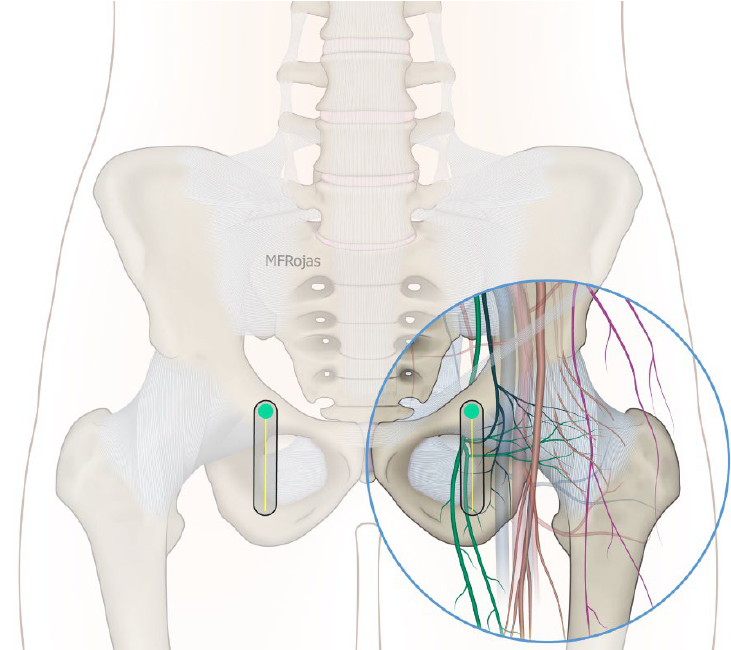
Figure 6. Schematic diagram showing the sagittal plane at the IMA with femoral vessels avoided. Reproduced with permission from Dr Maria Fernanda Rojas Gomez (Bucaramanga, CO). Green dot: transducer mark.